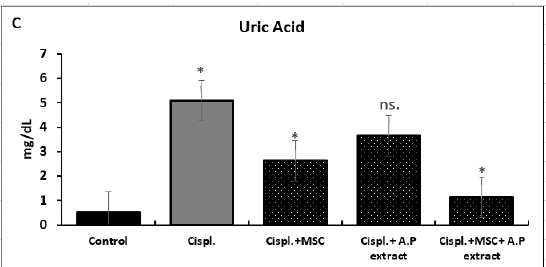
Figure 1. Kidney functions; creatinine, urea, and uric acid. C: control, Cispl.: positive control, Cispl. + MSC: cisplatin with mesenchymal stem cells, Cispl. + A.P extract: cisplatin with Asian pigeonwing extract, Cispl. + MSC + A.P: cisplatin with mesenchymal stem cells and Asian pigeonwing extract. ( A ) Creatinine, ( B ) urea, and ( C ) uric acid. Values are shown as mean ± SD and ns ( p > 0.05), * ( p < 0.05), ** ( p < 0.01), *** ( p < 0.001) compared to the corresponding value in the control group.